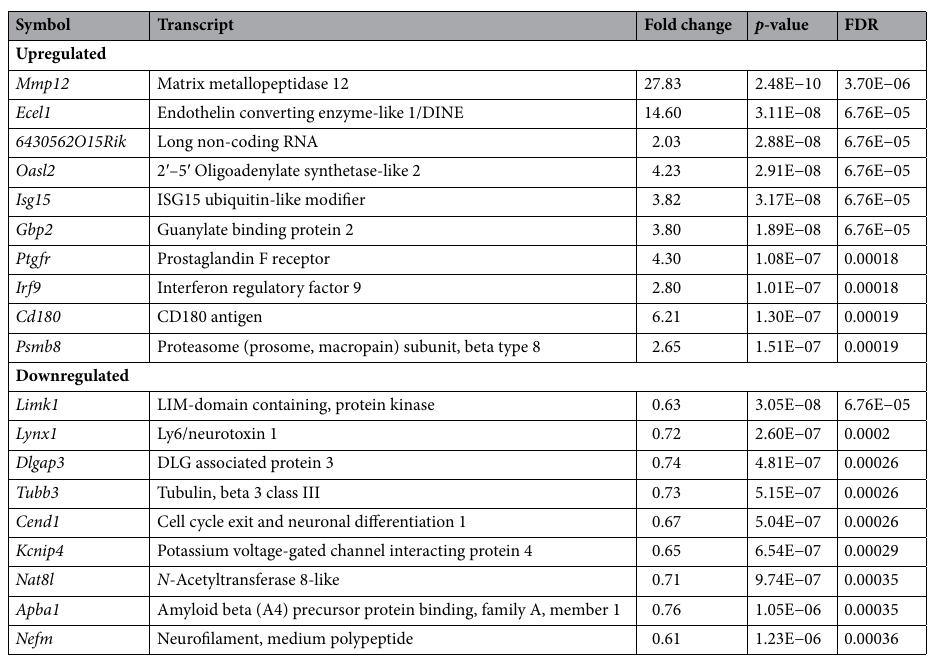
Table 2. Most highly up- or downregulated retinal transcripts in bTBI- versus sham-treated mice at 1-week post injury detected by RNA sequencing. FDR false discovery